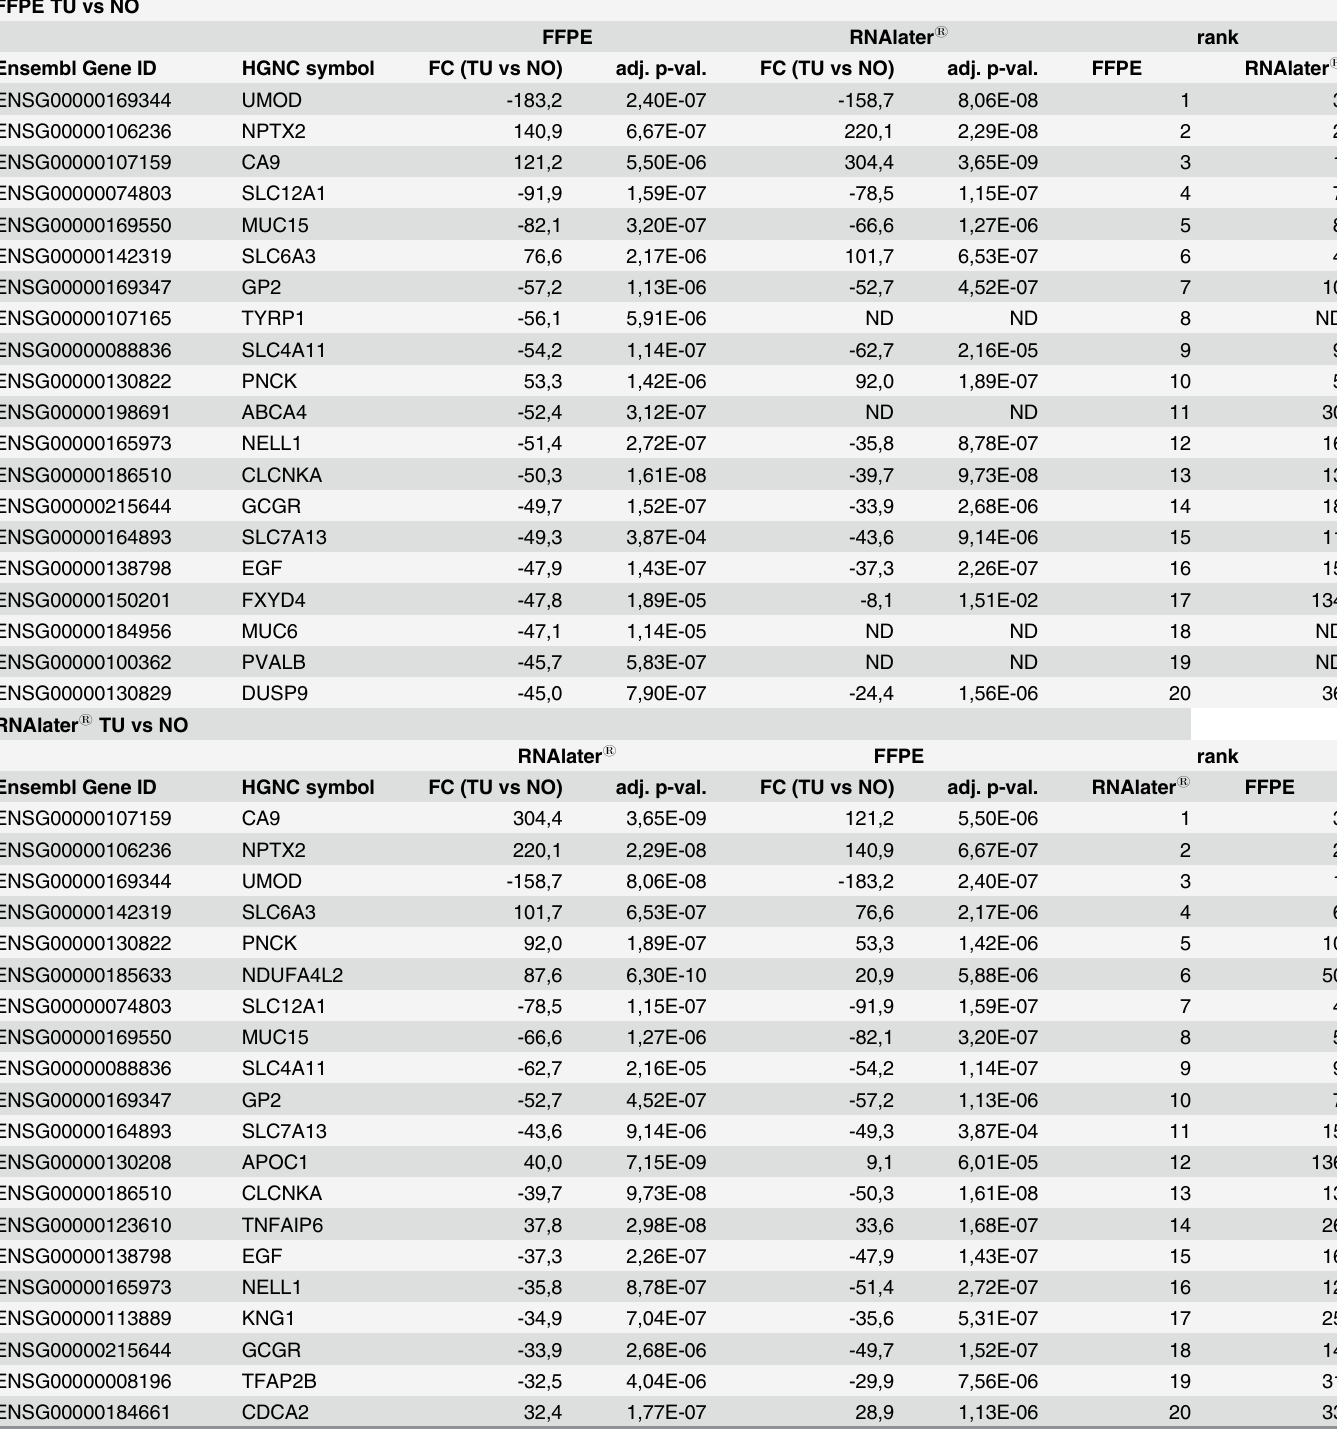
Table 2. Gene expression analyses. The 20 most up- or down-regulated genes in the FFPE data set with corresponding RNAlater 1 values (upper panel), and the 20 most up- or down regulated genes in the RNAlater 1 dataset with corresponding FFPE values (lower panel), filtered by adjusted p-value (cid:1) 0.05. Rank indicates the rank of the gene within the list of differentially genes sorted by largest to smallest absolute fold change. 14 genes are shared between the two lists. TU : tumour , NO : normal , FC : fold change , ND : not detected , did not pass the expression filter . FFPE TU vs NO FFPE RNAlater